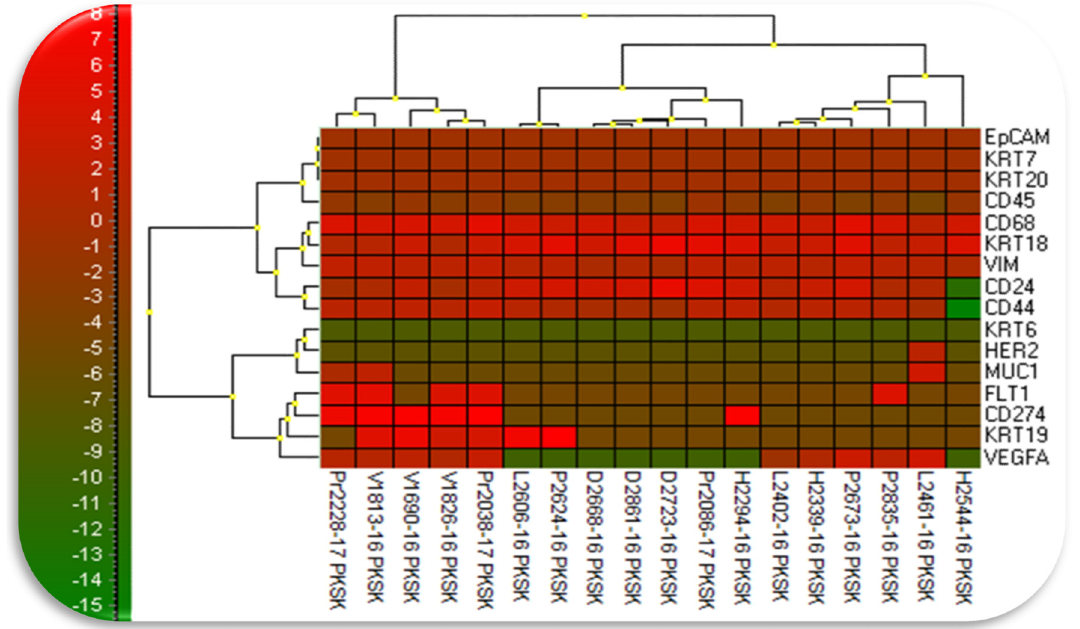
Figure 6. Relative RNA amount displayed in clusters after gene expression analysis using GenEx vs.6–software. (MultiD Analyses AB, Goteborg, Sweden). Clear distinction between CTCs expressing PD-L1 is shown (see arrow-cluster on the left).